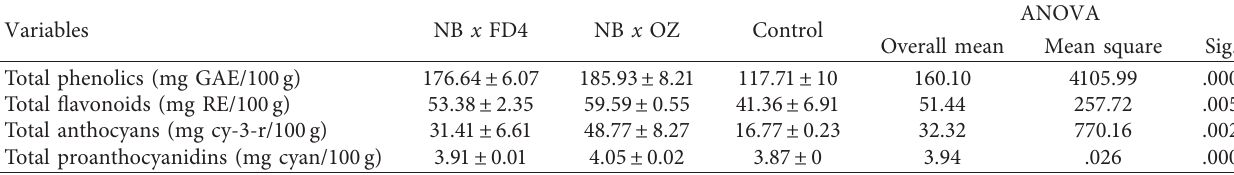
Table 1: Statistical analysis of biochemical traits of fig seeds as affected by